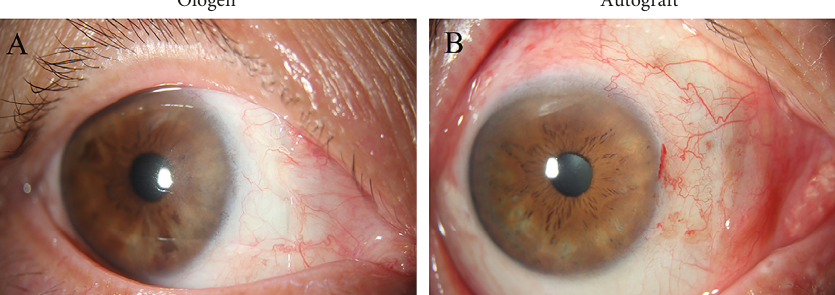
Figure 2: (a) Postoperative photo of Ologen group 1 month after surgery. (b) Postoperative photo of conjuntival autograft group 1 month after surgery.